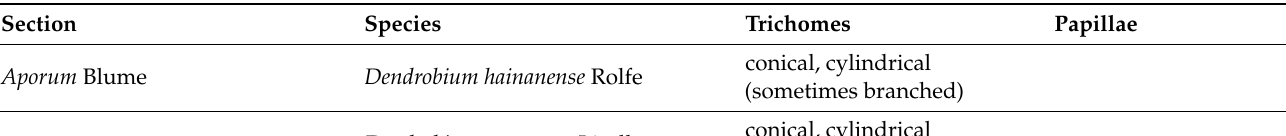
Table 1. Types of labellar structures found in all Dendrobium species researched in this paper, which have trichomes or papillae.